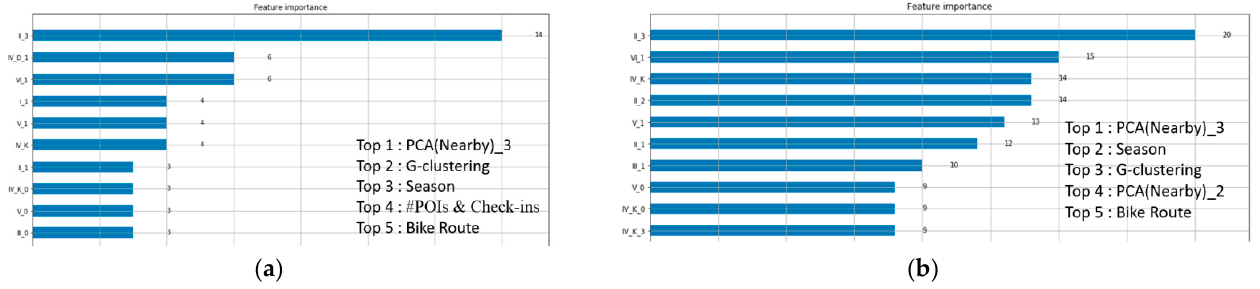
Figure 11. Feature importance of Batch 3. ( a ) Represents rental demand, and ( b ) represents the drop-off one.